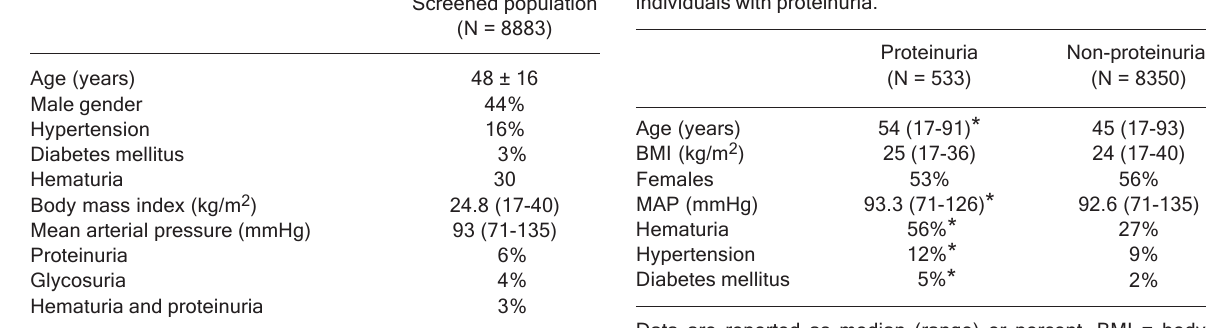
Table 3. Clinical characteristics and dipstick abnormalities of